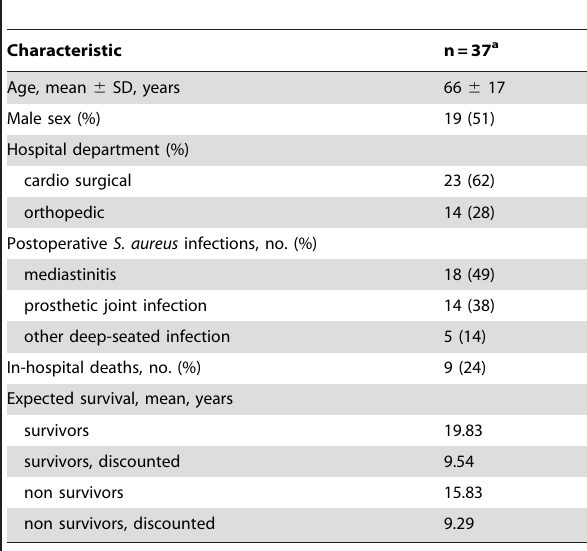
Table 2. Life expectancy of patients with deep-seated postoperative S. aureus